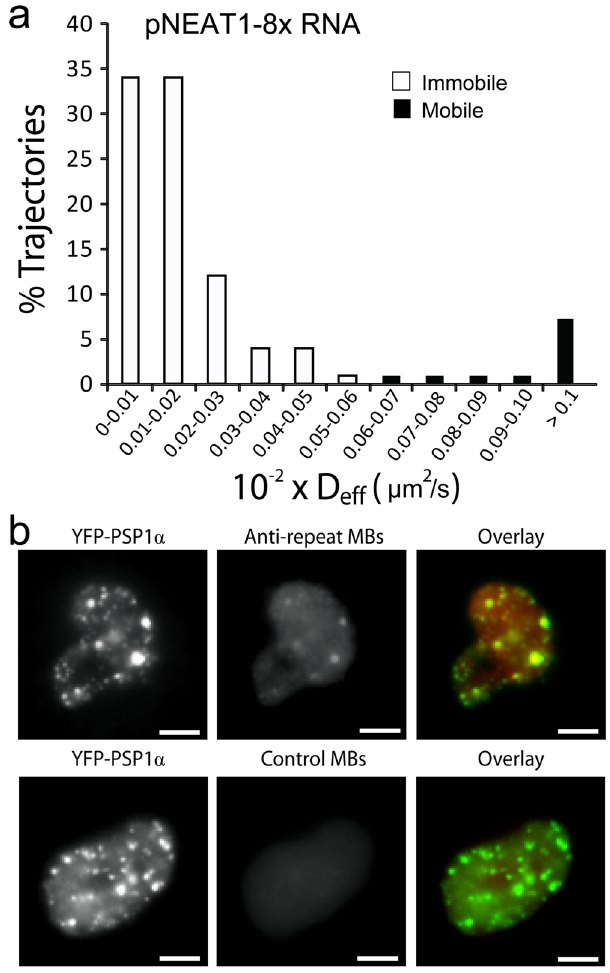
Figure 3. MB-based imaging of single NEAT1 transcripts in the nucleus. ( a ) Diffusion kinetics of single engineered NEAT1 lncRNA transcripts in the nucleus. HeLa-NEAT1-8x cells were microporated with 5 µ M anti-repeat MBs, and time-lapse images were acquired 8 h after microporation (See Movie S6). Single particle tracking analysis was performed to determine the diffusion coefficient of individual RNAs as described in Materials and Methods. The distribution of diffusion coefficients of single mobile pNEAT1-8x RNAs in the nucleus (n = 200 tracks) were analyzed from 25 cells. Data representing immobile tracks (D eff < 0.0006 µ m 2 /s as defined by immobilized Tetraspek beads) are highlighted in white. Data representing mobile tracks are highlighted in black. 89% of the detected engineered NEAT1 transcripts are immobile. ( b ) Live-cell detection of NEAT1 colocalization with PSP1 α proteins. 5 µ M of anti-repeat MBs or control MBs were injected into HeLa- NEAT1-8x cells transfected with pEYFP-PSP1 α constructs. Representative fluorescent images acquired within a few minutes post-injection are shown. (Scale bar, 10 µ